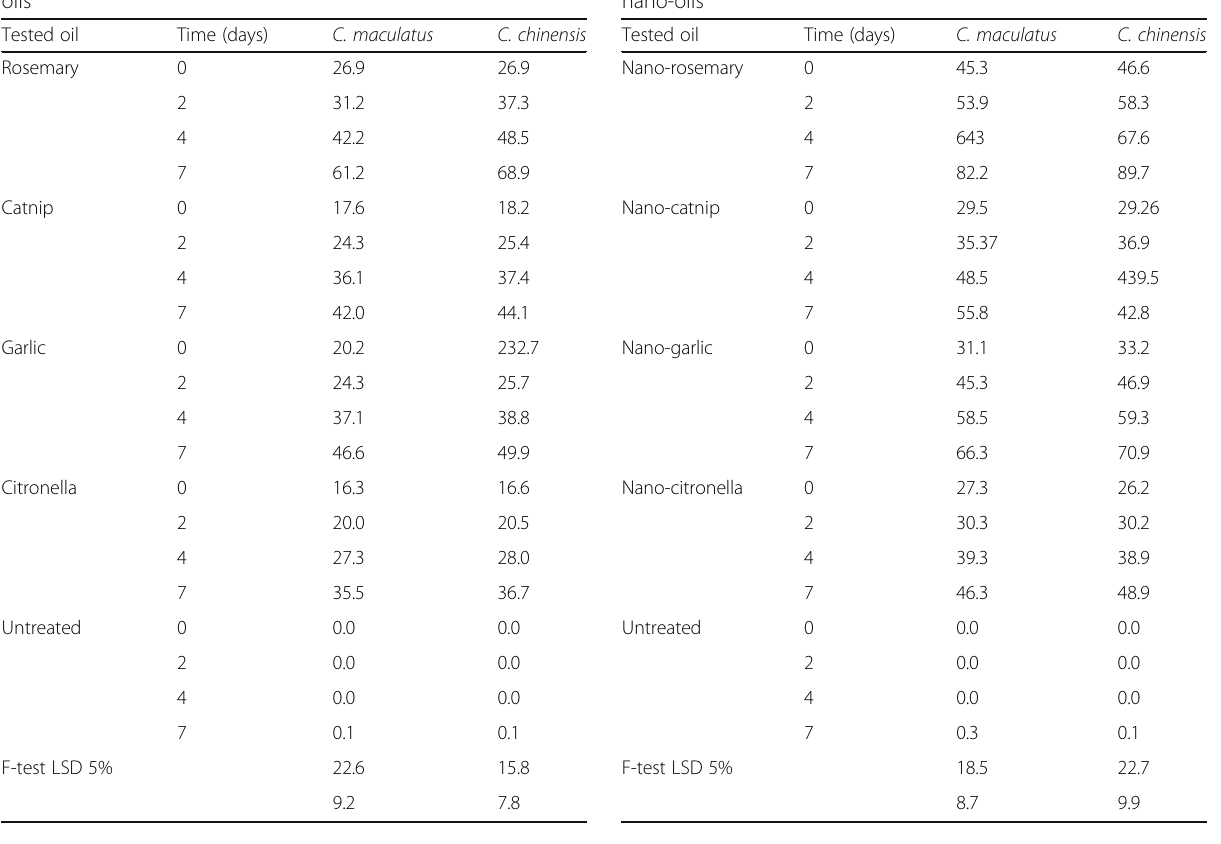
Table 2 Accumulations mortality of target adult pests